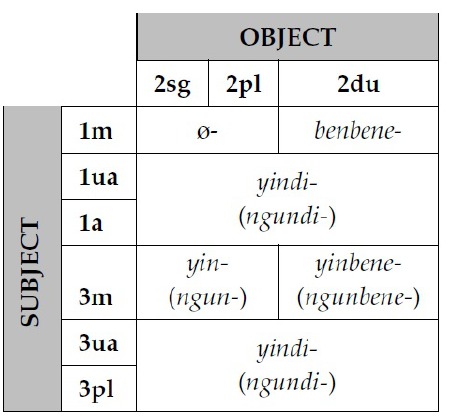
Table 6. Regularised second person object